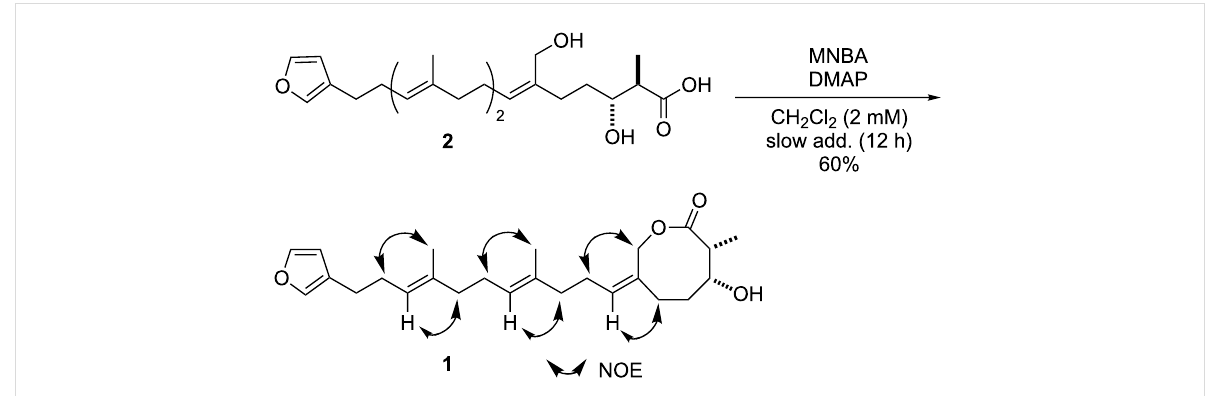
Scheme 3: MNBA-mediated